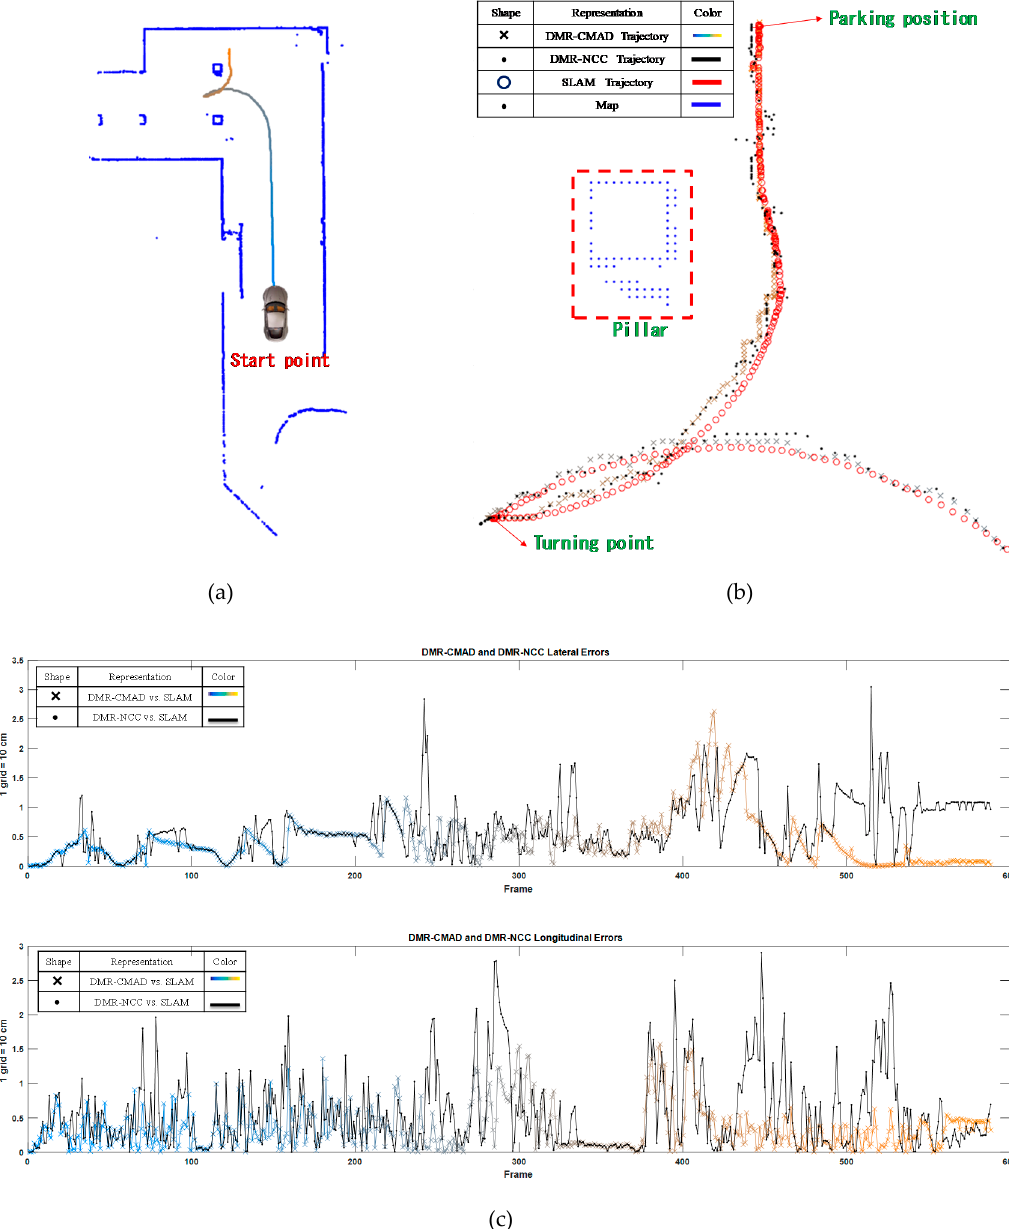
Figure 15. Comparison of the DMR–CMAD and DMR–NCC trajectories and the SLAM trajectory. ( a ) DMR–cross mean absolute difference (CMAD) trajectory. ( b ) Local magnification (when the car was reversing). ( c ) Lateral and longitudinal errors between the DMR–CMAD and DMR–normalized cross-correlation (NCC) trajectories and the SLAM